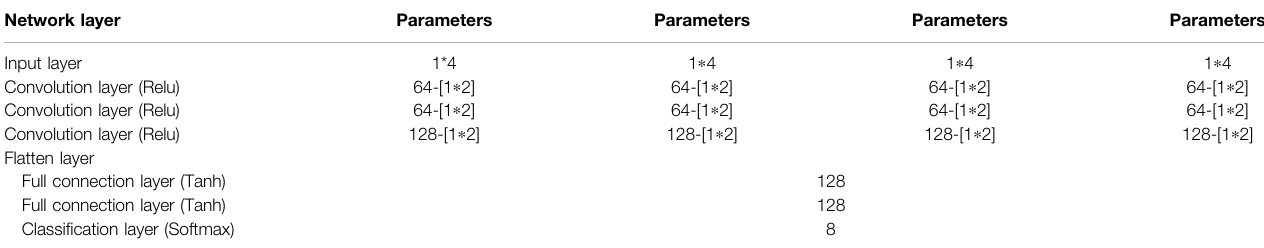
TABLE 5 | Life prediction model